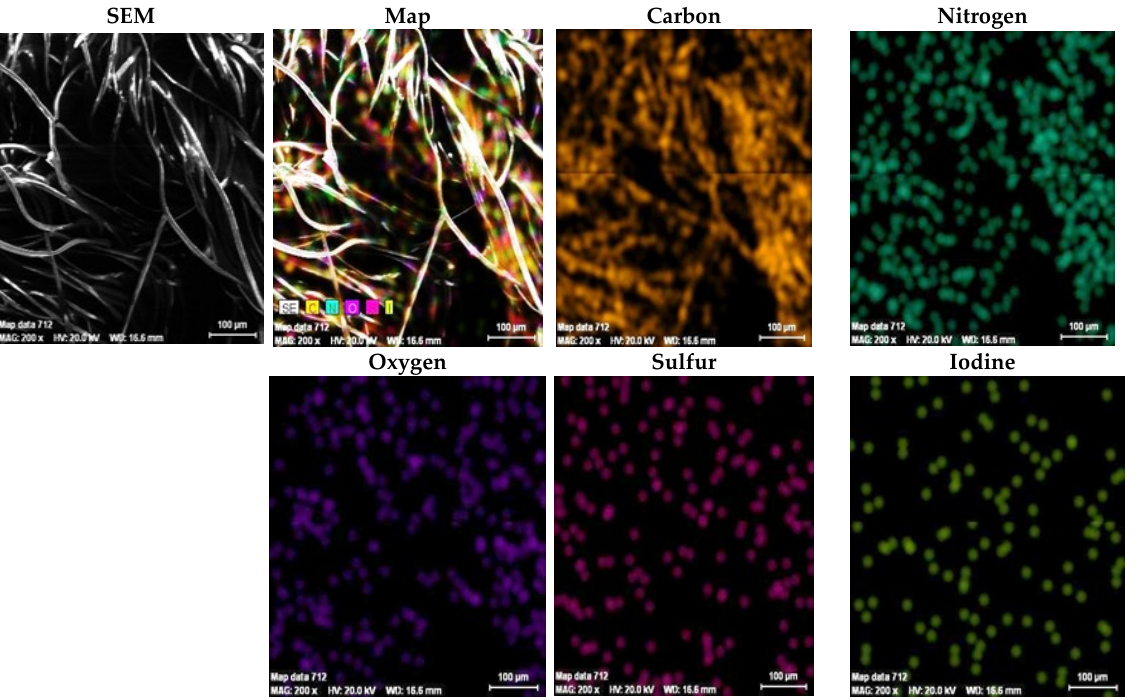
Figure 9. SEM image and element mapping in functionalized Melana fibers.